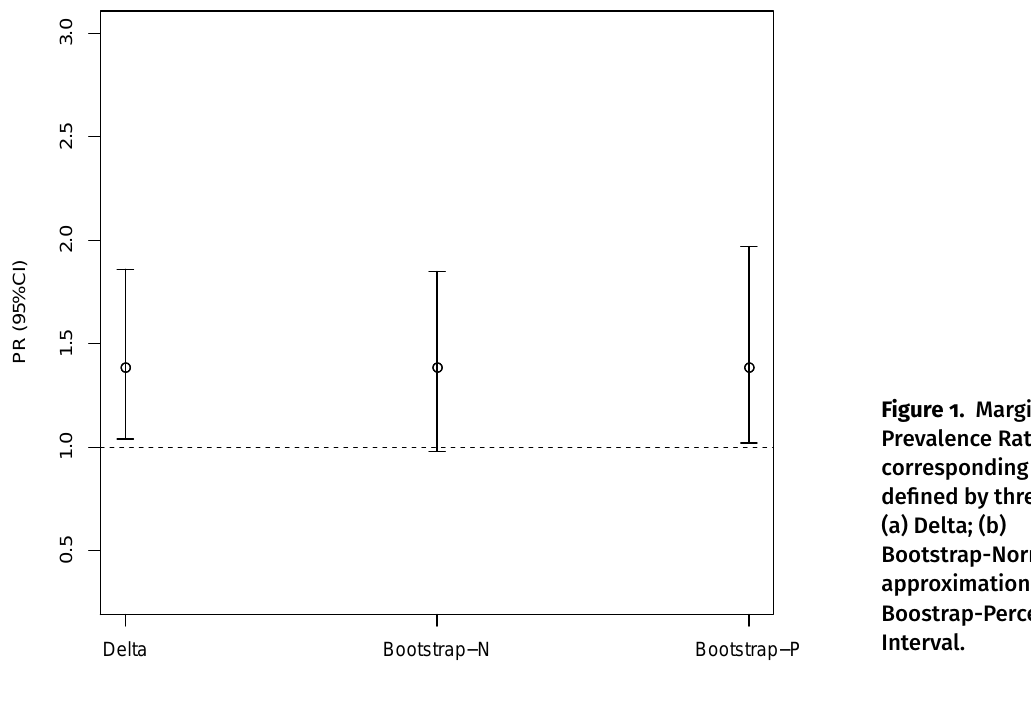
Figure 1. Marginal Prevalence Ratios (PR) and corresponding 95% CIs defined by three methods: